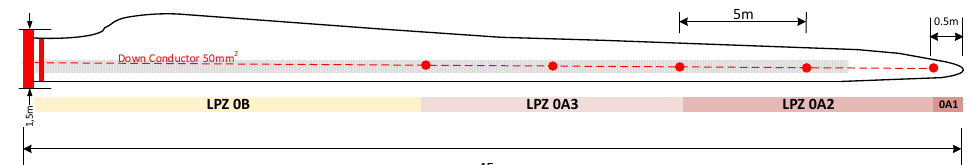
Figure 7. Conceptual blade design including standard LPS.